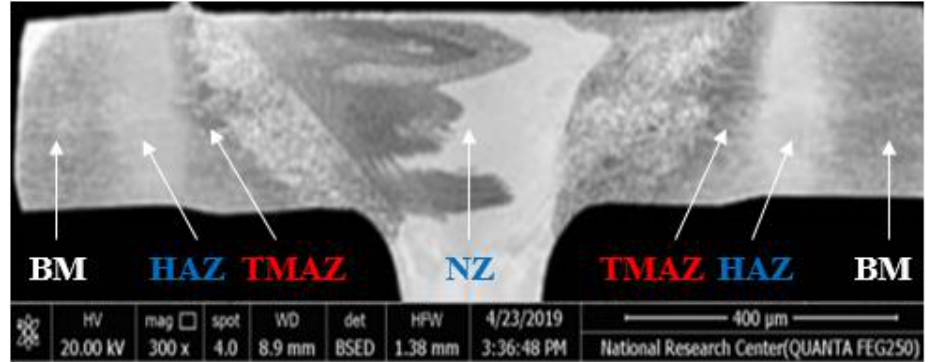
Figure 9. Zones in optical microscopic image of T-joint cross-section.